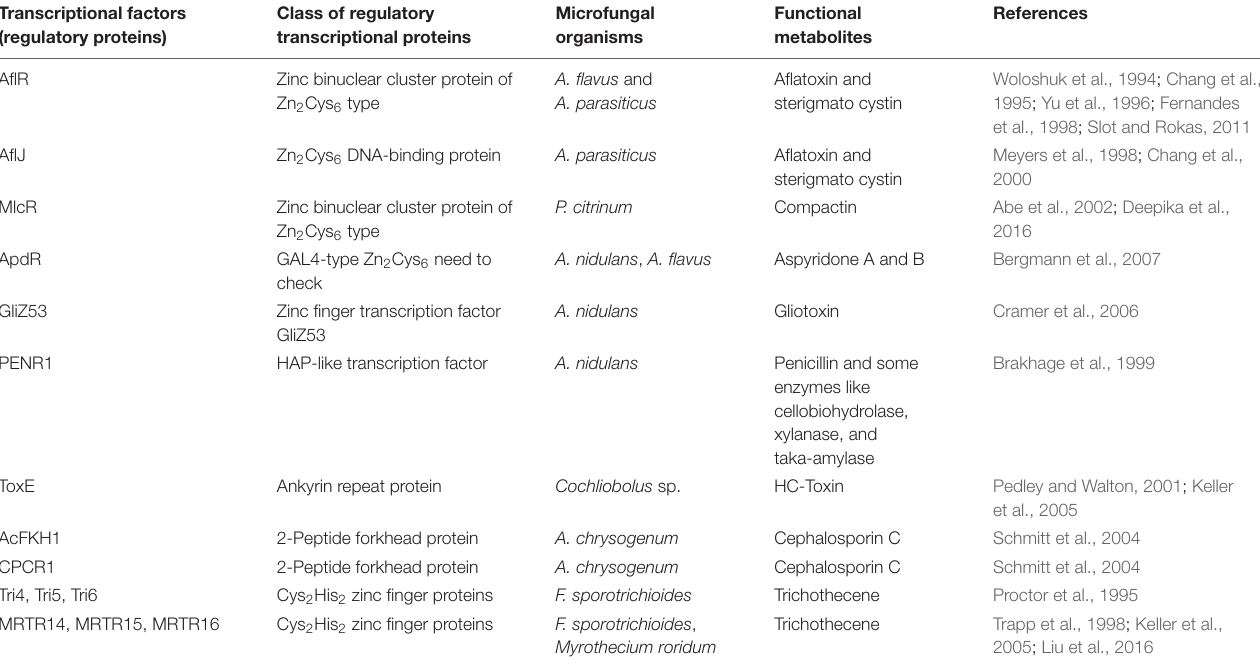
TABLE 1 | Narrow domain transcription factors